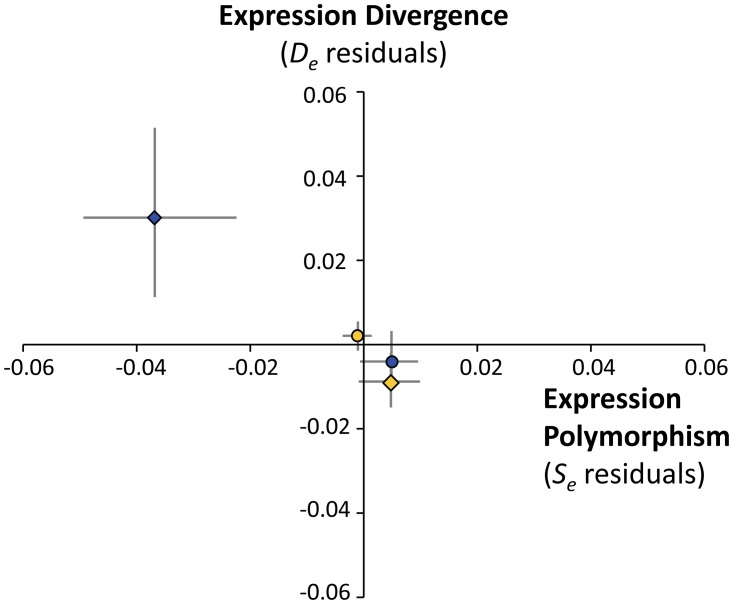
Multiple-regression residuals of gene expression divergence and polymorphism (mean) for X-linked male-biased genes (MBGs) (blue diamonds), autosomal MBGs (blue circles), X-linked nonsex-biased genes (NBGs) (yellow diamonds), and autosomal NBGs (yellow circles).Grey lines represent 90% confidence limits of the residual means.